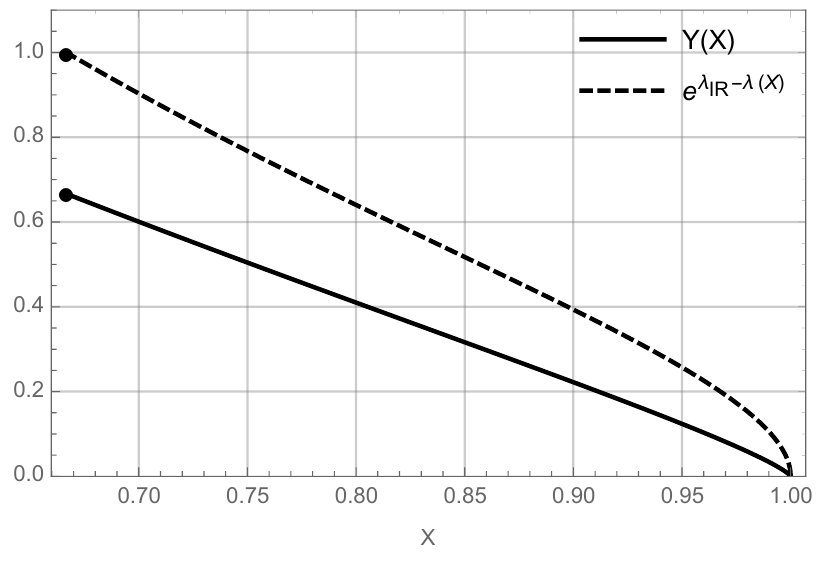
Figure 3 . The full analytic solution for the functions Y ( X ) and (cid:21) ( X ) in the case p = 2. The UV region is at X = 1, Y = 0 and the IR region is indicated by the solid